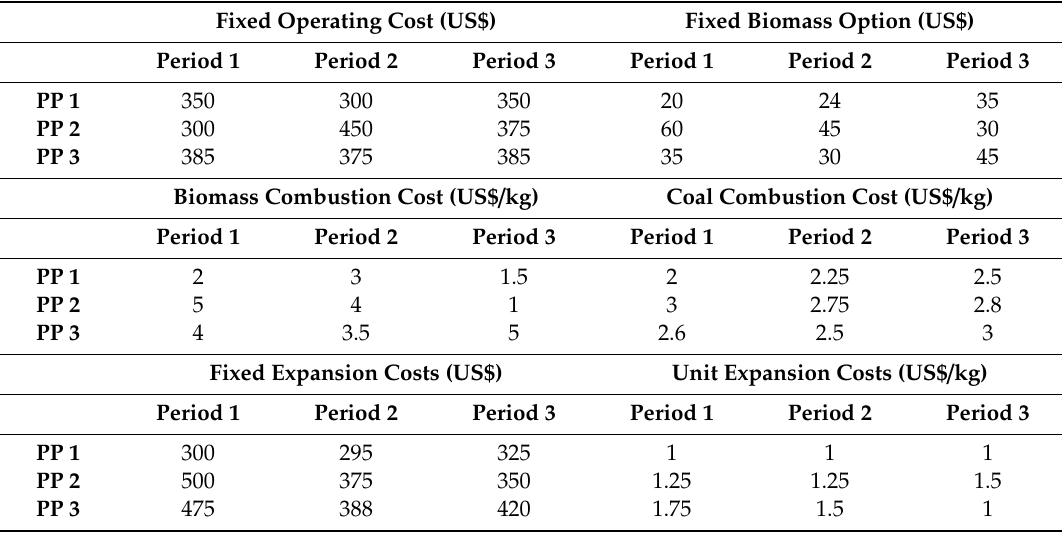
Table A5. Power Plant Costs.